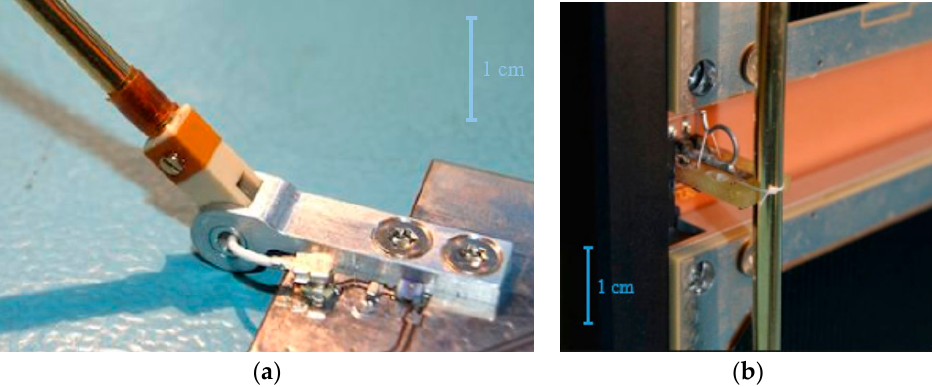
Figure 6. ( a ) Hinge and ( b ) hold-down and release mechanism for the antennas (Credit: GOMspace).